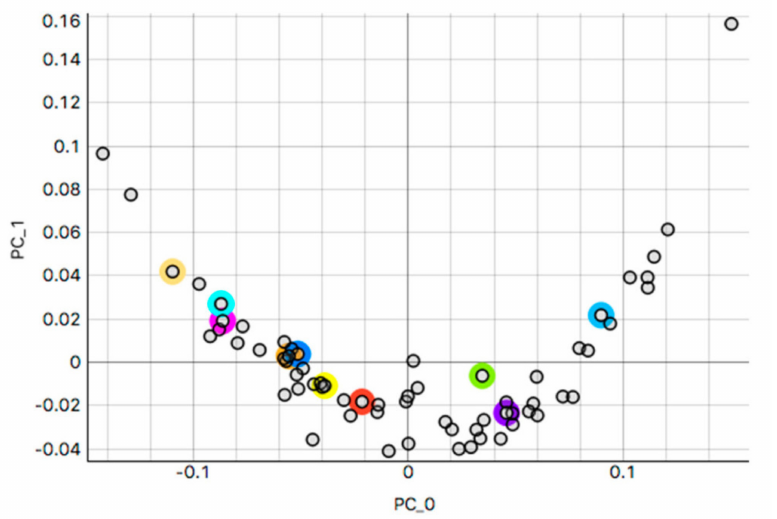
Figure A1. Scatterplot of kidney examples along the first two principal components; the highlighted colors show the same random laboratories as in Figure 4, and names are not shown directly due to visual